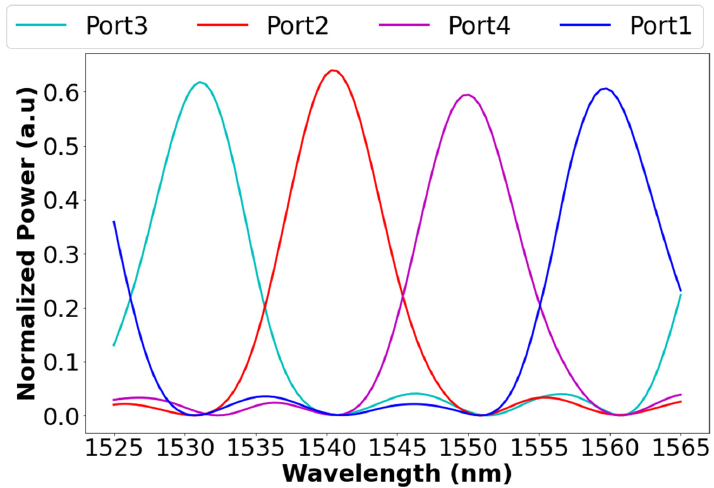
Figure 7. Normalized power relative to the input in each port as a function of wavelength in the C-band spectrum.